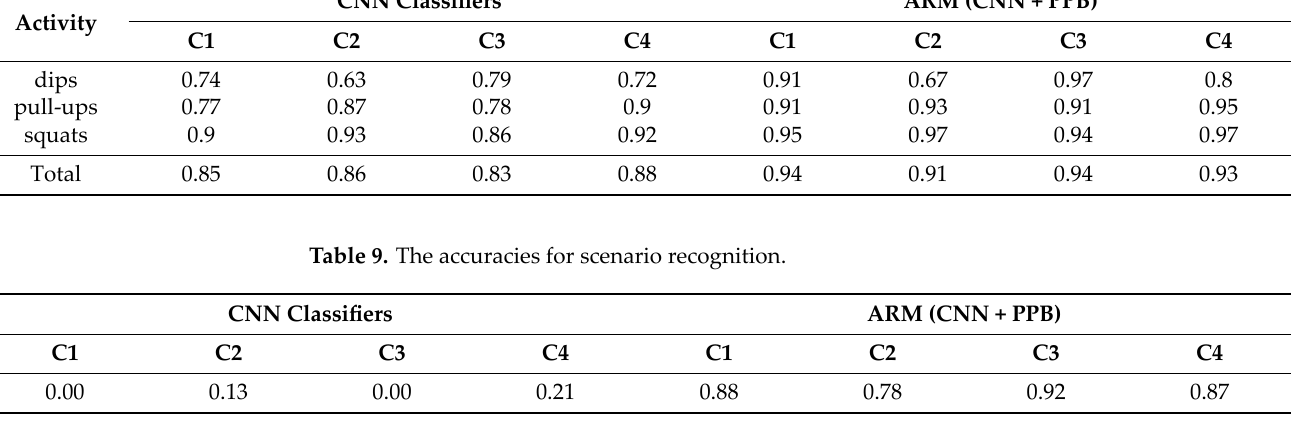
Table 9. The accuracies for scenario recognition.